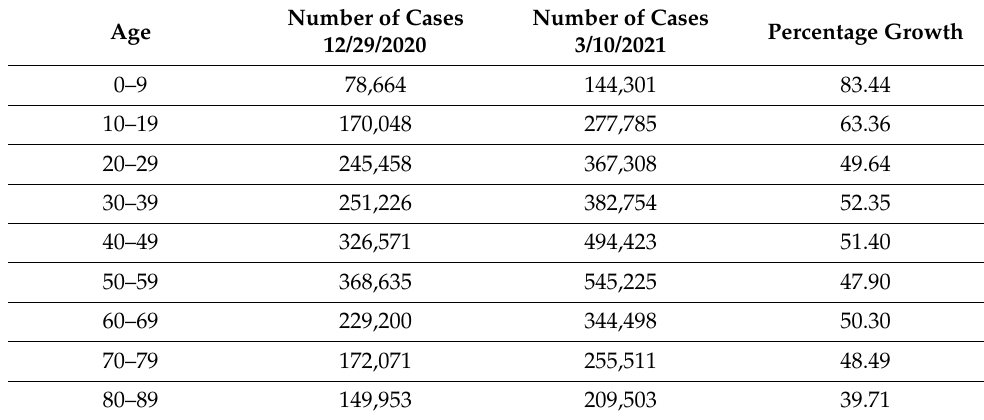
Table 1. The trend of infections between 29 December 2020 and 10 March